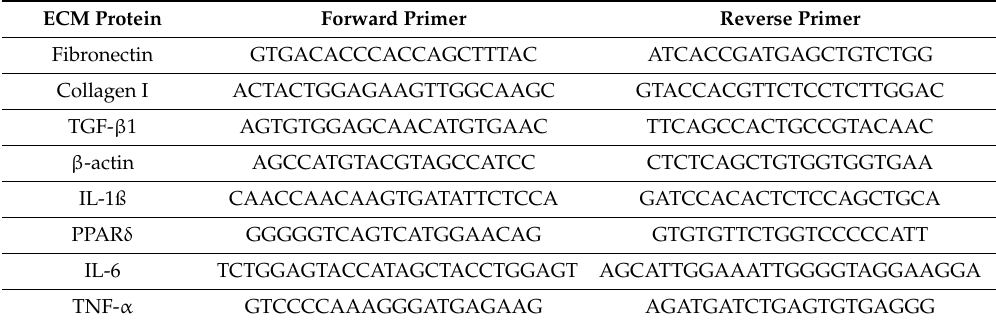
Table 1. Primers used to determine mRNA